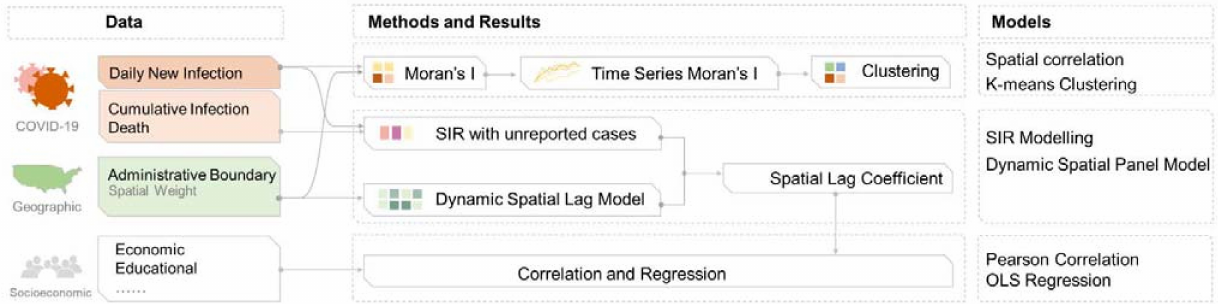
Figure 1. Research workflow. The research workflow can be divided into three parts: (1) data, including epidemiological, spatial, and socioeconomic data; (2) methods and results, including the mapping, estimation, and correlation exploration of spatiotemporal interaction effects; and (3) models, including Moran’s I , K -means clustering, SIR, SLM, and